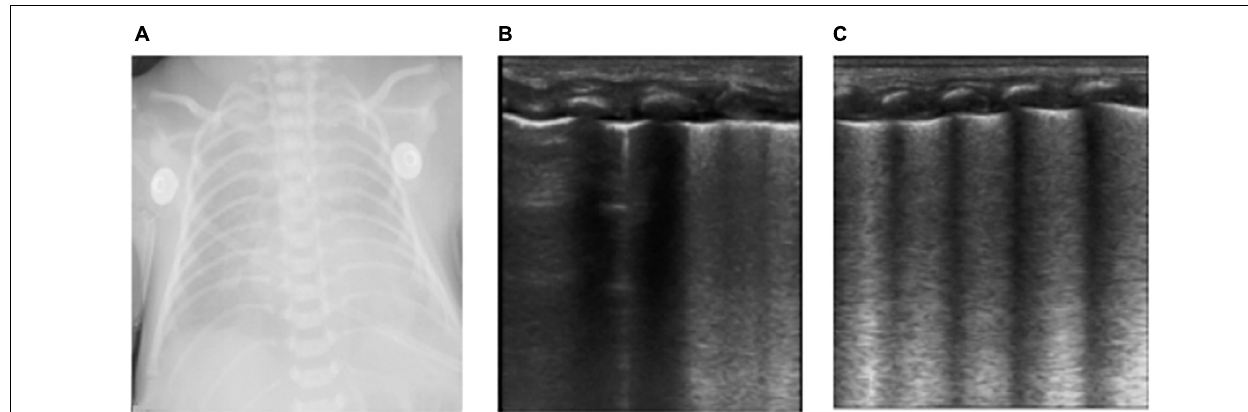
FIGURE 1 | The neonate was born at 36 weeks of gestational age by Cesarean section due to the mother’s central placenta previa hemorrhage. The amniotic fluid was clear, and the Apgar score of 1, 5, and 10 min of birth were 10 points. The neonate had labored breathing and shortness of breath 10 min after delivery and mechanical ventilation was required. It was diagnosed as severe wet lung. (A) Chest X-ray: Lung permeability decreases, and the white lung changes. (B,C) Ultrasound findings: Rough pleural line, reduced A-line, alveolar interstitial syndrome (AIS), double lung points but no consolidation, which conforms to the ultrasonic characteristics of wet lung. After 24 h of treatment, the neonate’s breathing improved. LUS showed that B-lines was significantly reduced and the patient was successfully evacuated from the ventilator. The clinical outcome was consistent with the characteristics of wet